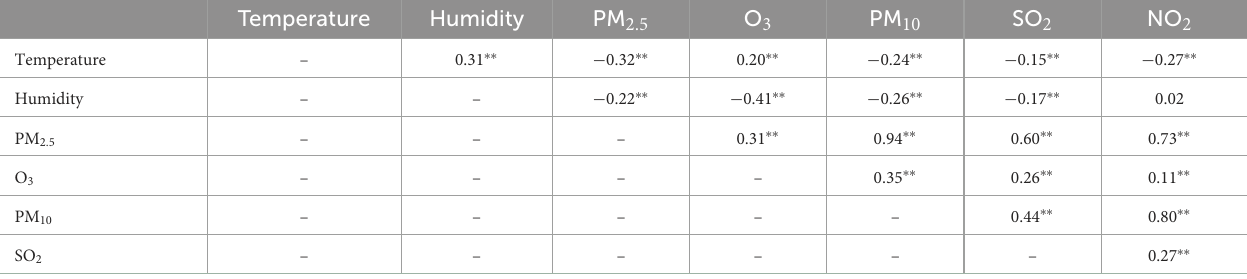
TABLE 2 The correlation coefficients between PM 2.5 , PM 10 , and other pollutants.